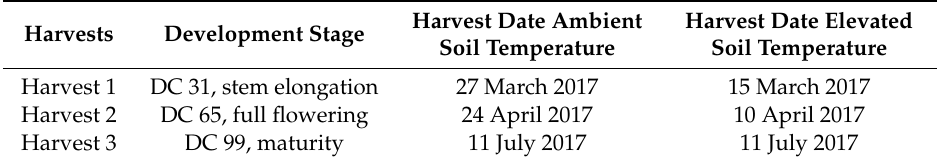
Table 2. Harvest dates of OSR depended on the development stage of plants. Harvest 1 and harvest 2 of OSR plants grown under ambient soil temperature were performed about two weeks later than under elevated soil temperature. OSR was sown on 7 September 2016. The development stage is expressed as BBCH decimal code (DC)